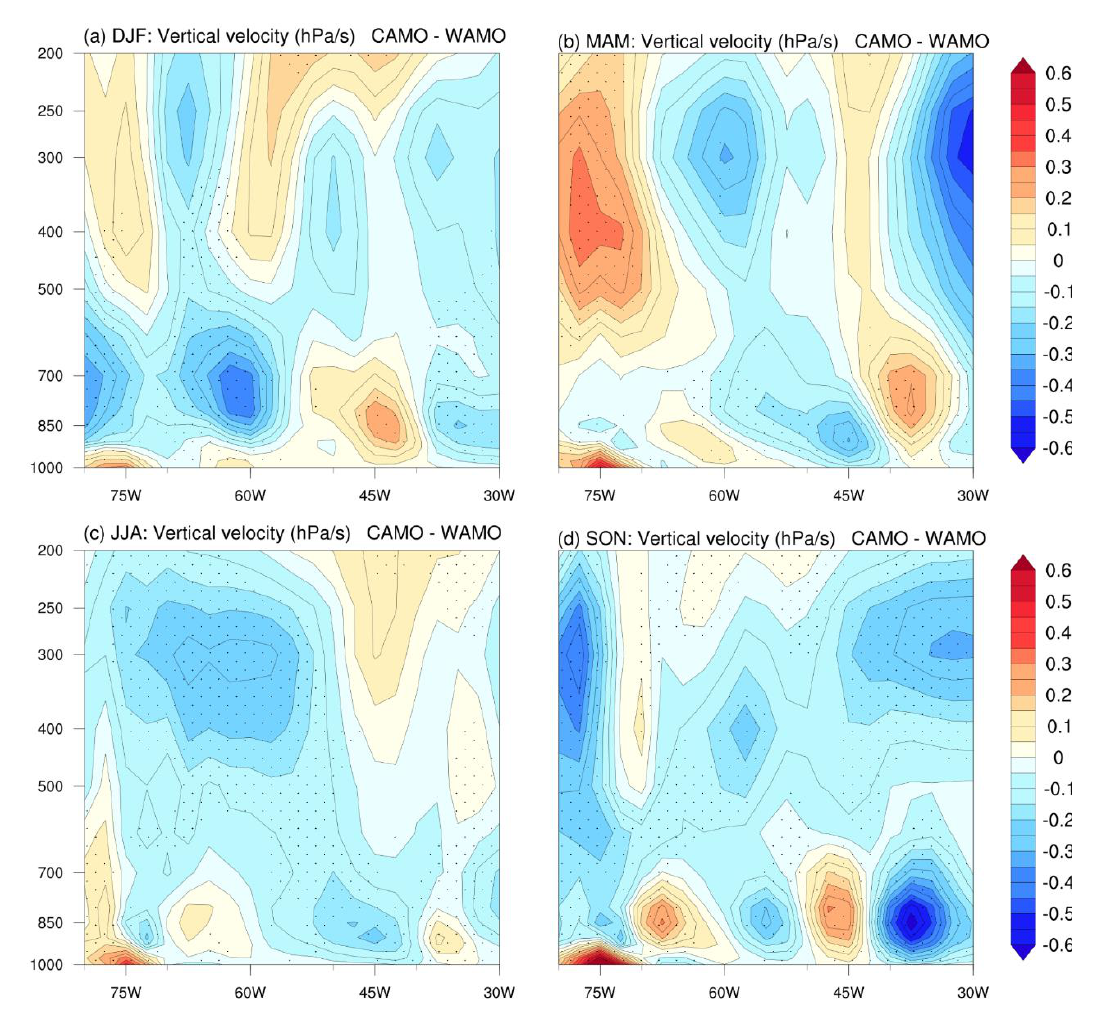
Figure 9. Difference between CAMO and WAMO of vertical pressure velocity (omega; hPa/s) meridionally averaged over 0° – 15°S, representing the regional Walker circulation for ( a ) December – February (DJF), ( b ) March – May (MAM), ( c ) June – August (JJA), and ( d ) September – November (SO N). Stippled areas represent statistically significant (Student’s t test at 95%) differences.